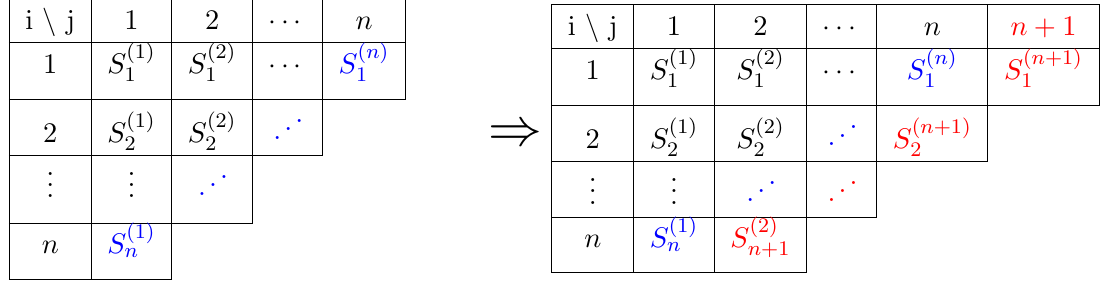
Figure 5: The current triangle (left) and the next year triangle (right). The present is outlined in blue and Figure A1. The current triangle ( left ) and the next year triangle ( right ). The present is outlined in blue the one-year ahead future in red. Merz-W¨uthrich method allows to compute the ultimate on both triangles and the one-year ahead future in red. The Merz–Wüthrich method allows for computing the ultimate and calculate the uncertainty of the difference. risk on both triangles and calculate the uncertainty of the